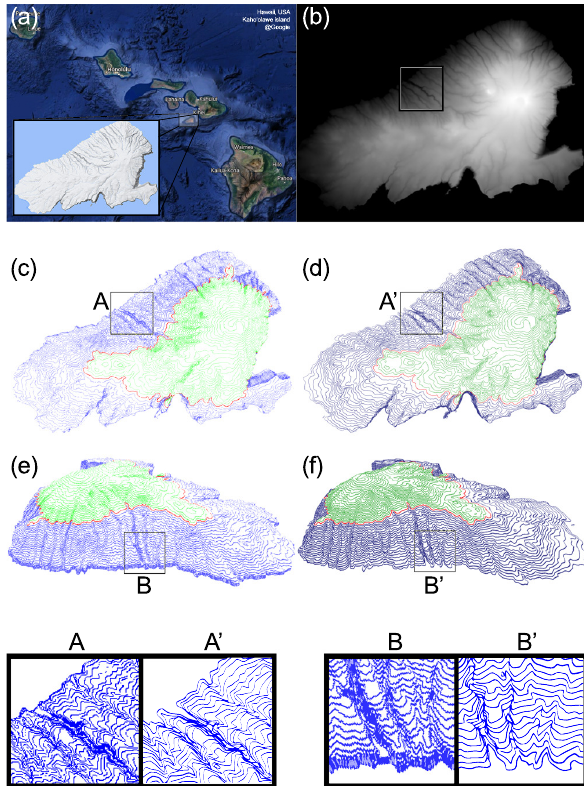
Figure 10. Implicit surface model with a real data set: (a) Kaho’olawe, Hawaii’s island Google maps; (b) input depth map; (c) and (d) top views and (e) and (f) side views; discreet output are shown in (c)+[A] and (e)+[B]; and implicit curve output in (d)+[A’] and (f)+[B’].